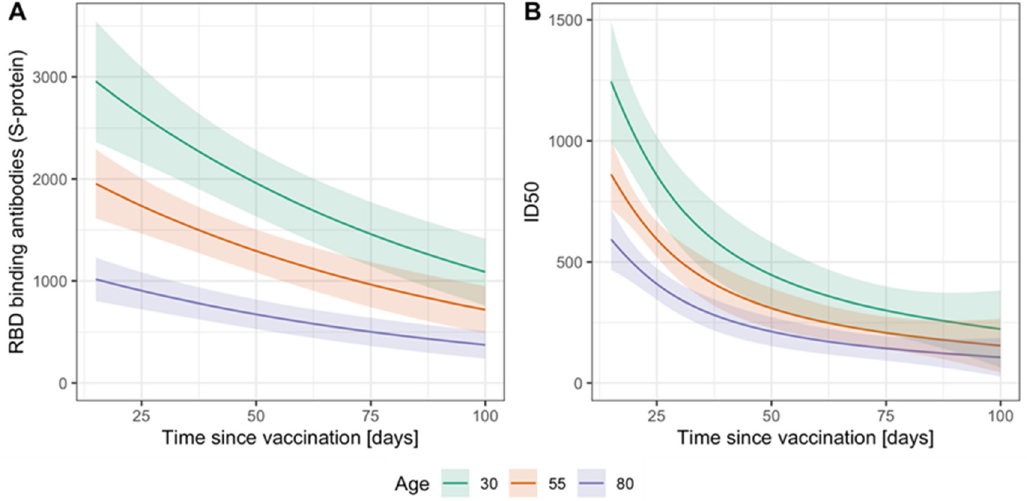
Figure 3. Model-based RBD binding and neutralization antibody levels related to age and time since vaccination. We applied a generalized additive model with assumed log-normal distribution of the antibody levels and non-linear associations with age and time since vaccination on the cross- sectional data from T3. On the example of individuals vaccinated twice with COV, we show predicted levels of ( A ) RBD binding antibodies (arbitrary units AU/mL) and ( B ) neutralizing antibodies (ID50) for the age of 30, 55, and 80 years and over the observed range of days since second vaccination ( n = 272 and 269, respectively). Shaded regions indicate approximate 95%-prediction intervals (Prediction ± 2×SE).